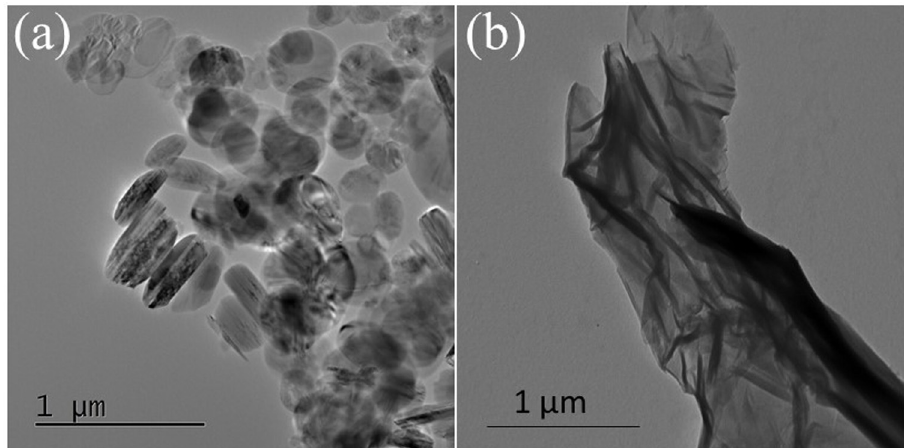
Figure 2: TEM images of ( a ) BN nanoparticles and ( b )